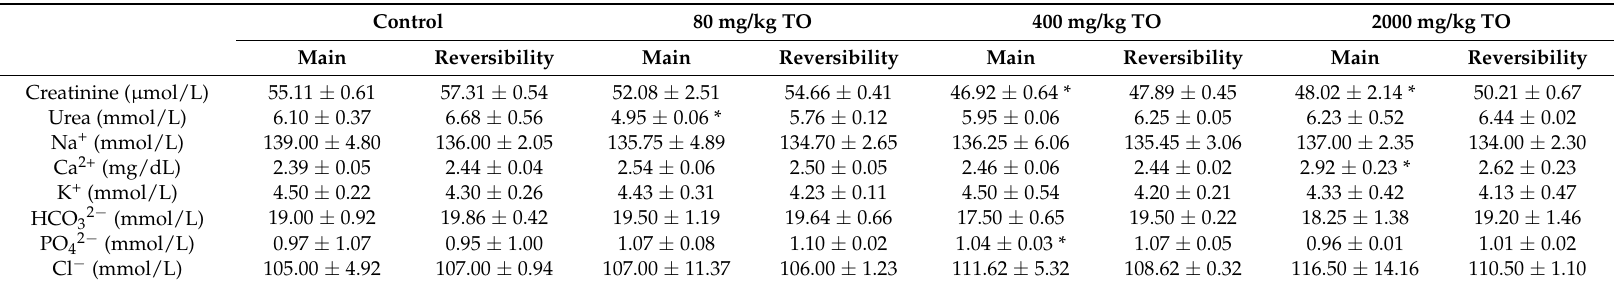
Table 5. Effect of T. occidentalis on serum creatinine, urea and electrolytes.